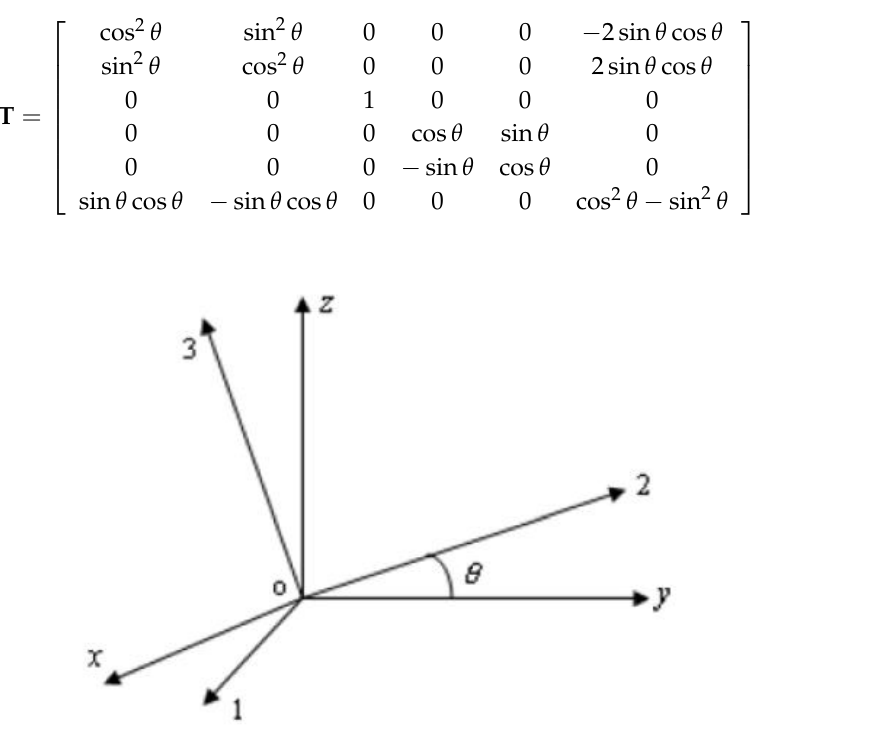
Figure 2. Relationship between two coordinate systems.